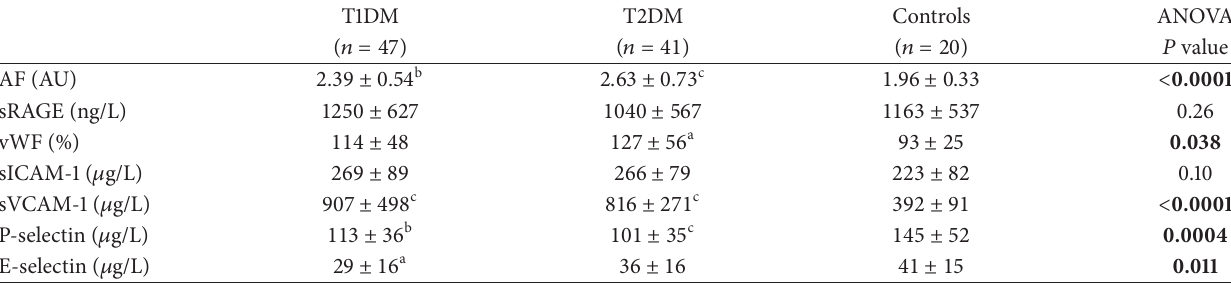
Table 2: Skin autofluorescence and novel biochemical